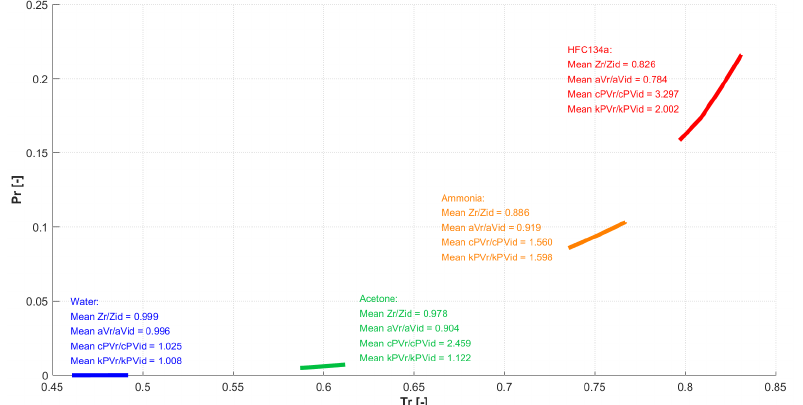
Figure 17. Paths followed by the four fluids in the evaporator during the thermal